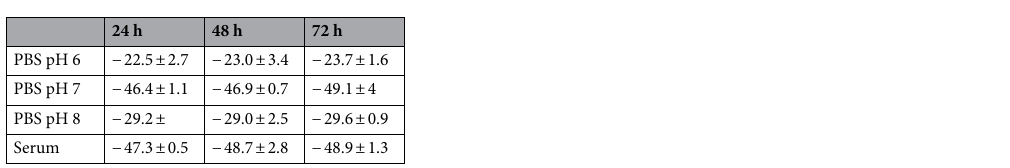
Table 2. Zeta potential (mV) of Au-NPs in PBS, 10% serum for 24 h, 48 h and 72 h.